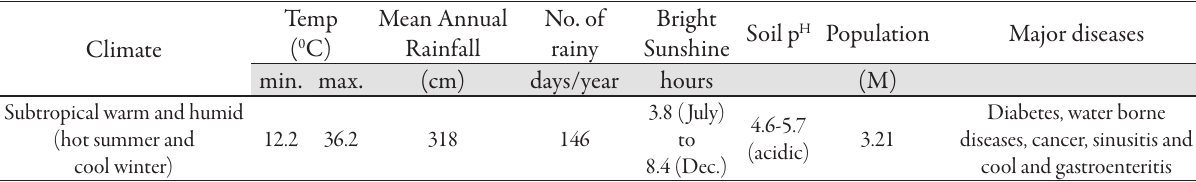
Tab. 1. Climatic and other features of the Barak Valley Zone Climate